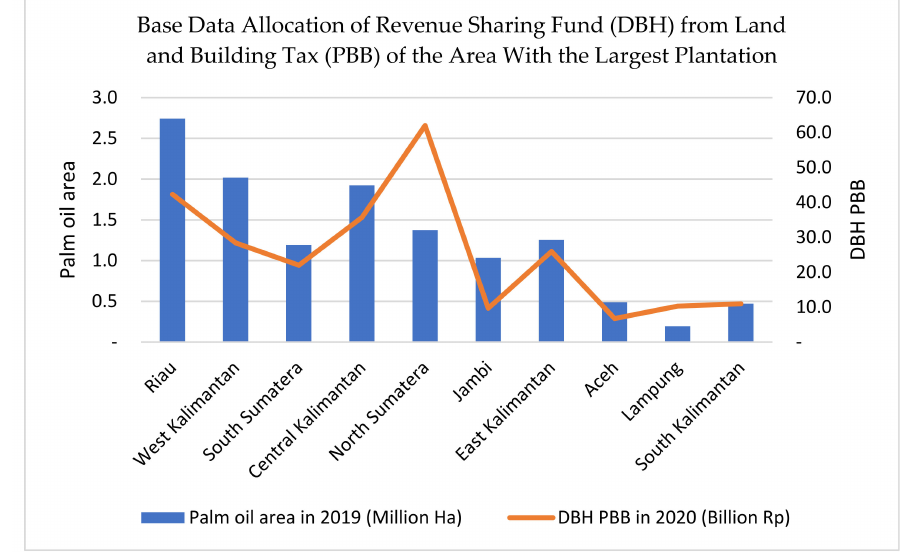
Figure 4. DBH funds from land and building taxes and their distribution across palm oil provinces 7